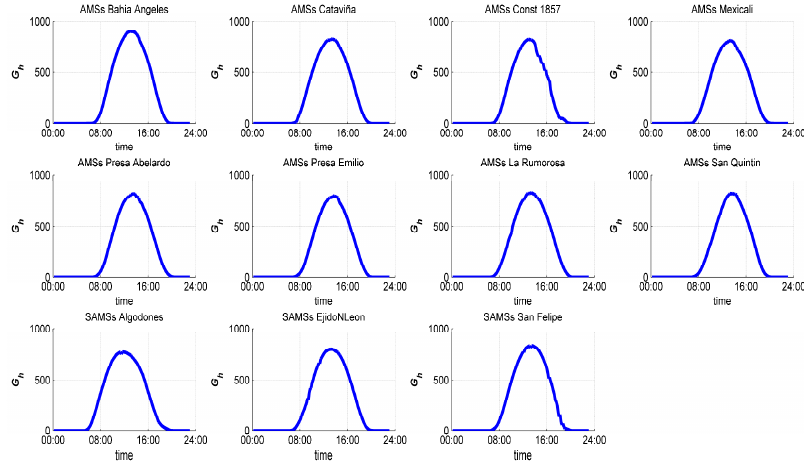
Figure 7. Daily irradiance patterns registered in Baja California.